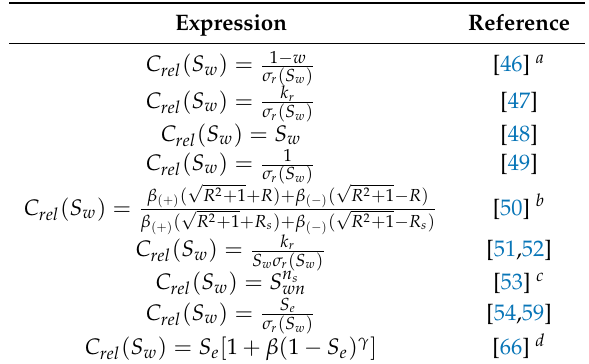
Table 1. List of the published models describing the dependence of the relative SPCC on water saturation. Notes: C rel is the relative SPCC; a w is the hydrodynamic resistance factor; b R represents the excess charge in the pore water of porous media; β is the mobility of the ions and R s is the quotient between R and S e ; c S wn and n s are the normalized water saturation and the exponent related to the excess of mobile counterions in the electrical boundary layer, respectively; and d β and γ are two fitting